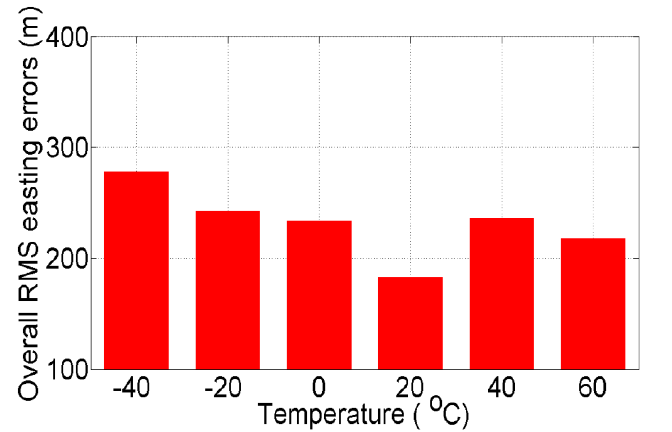
Figure 14. Overall RMS errors in easting using kinematic test data collected at +17 °C and the AR-based GM model developed at different temperature points.